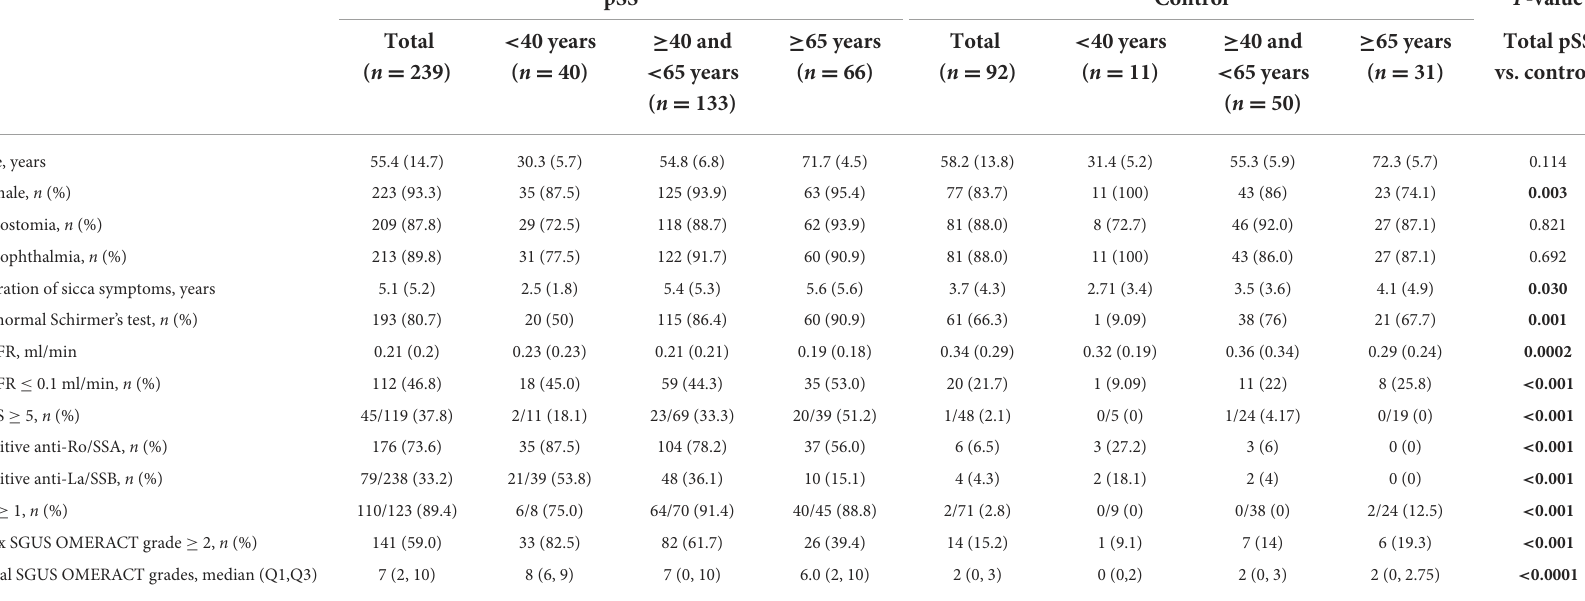
TABLE 1 Clinical and laboratory characteristics of the study